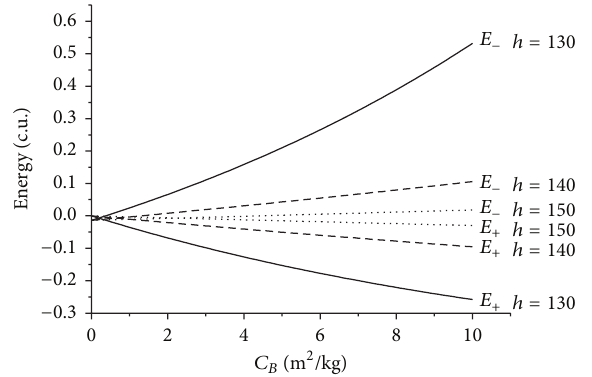
Figure 8: Evolution of the energies as a function of the ballistic coefficients for different values of the periapsis altitude for 𝜓 = 270 ∘